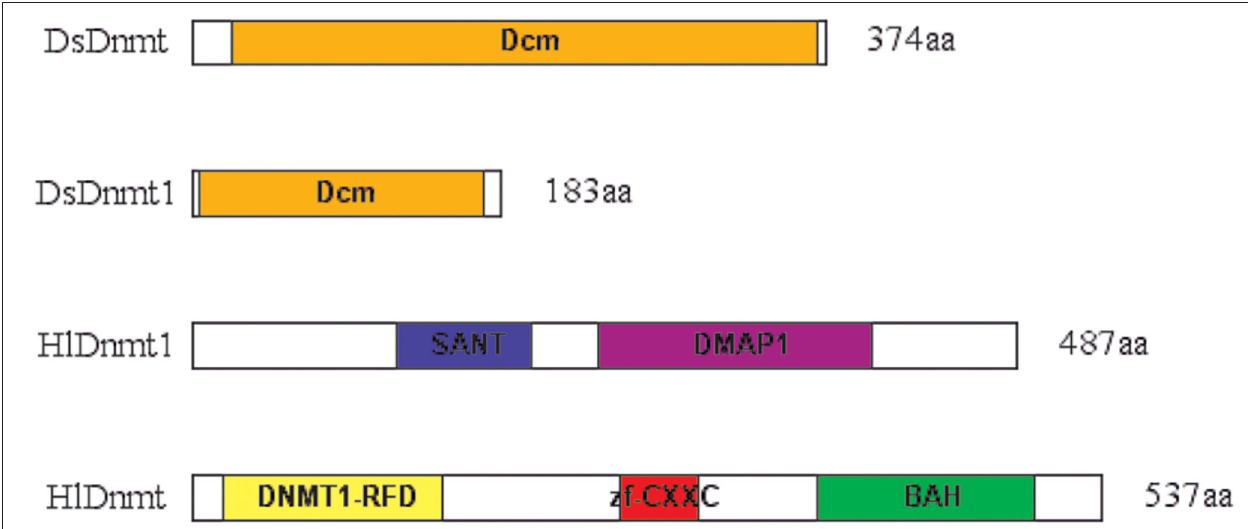
FIGURE 2 | Schematic presentation of conserved domains identified for the putative DNA methyltransferases of D. silvarum and H. longicornis . Putative DsDnmt and DsDnmt1: orange—Dcm domain; putative HlDnmt1: blue—SANT domain, purple—DMAP1 domain; putative HlDnmt: yellow—DNA methyltransferase replication